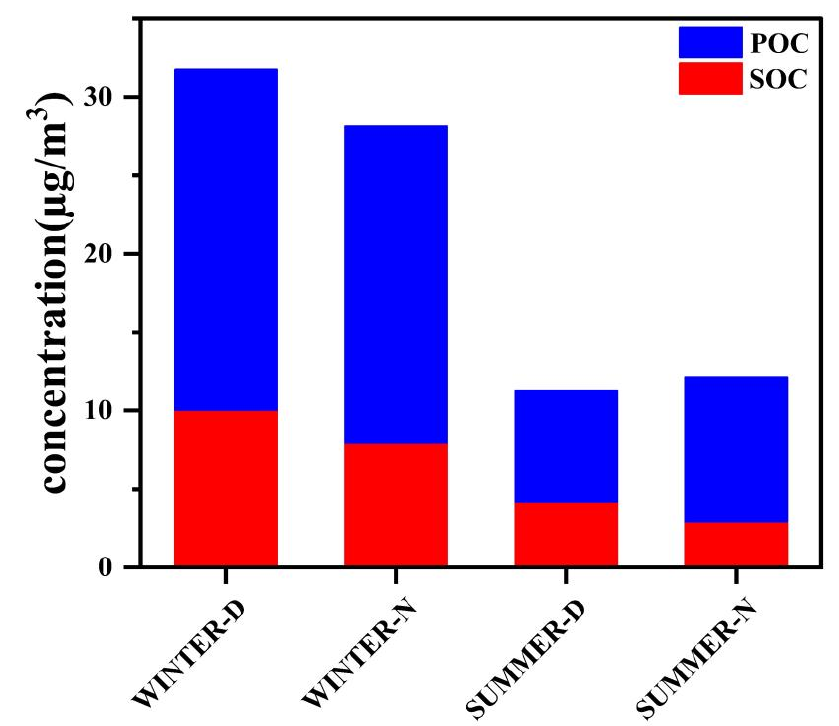
Figure 4. Average concentration of SOC and POC during daytime and nighttime in winter and summer (WINTER-D: winter daytime, WINTER-N: winter nighttime, SUMMER-D: summer daytime, SUMMER-N: summer nighttime).